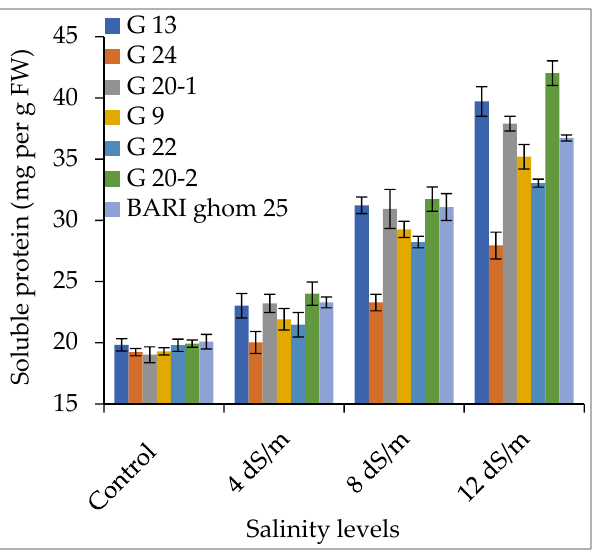
Figure 15. Soluble protein content in leaf of wheat genotypes under various salinity levels. The vertical bar indicates average data of five independent replicates ( n = 5). Error bars represent standard error.